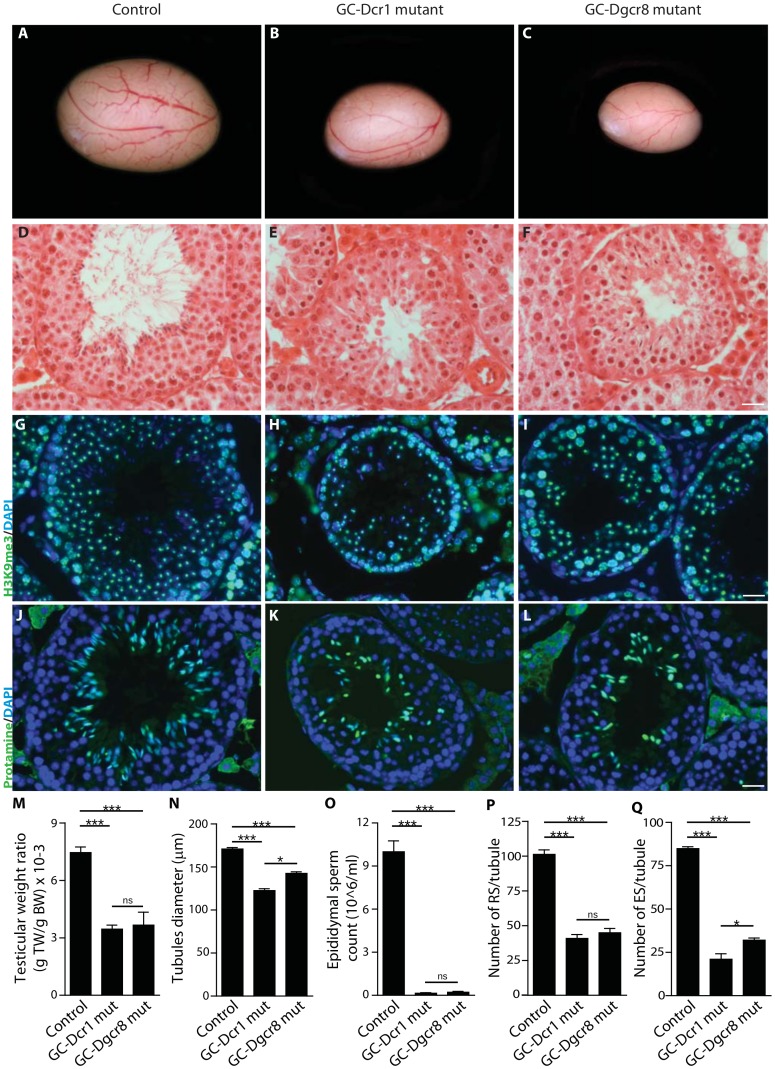
Reduction in testis size and near complete absence of mature spermatozoa in GC-Dcr1 and GC-Dgcr8 mutant mice.(A–C, M) At P60, testis weight showed a 55% and 50% reduction in GC-Dcr1 (n = 16) and GC-Dgcr8 mutants (n = 5) compared to control testes (n = 17). H&E staining of testis sections (D–F) revealed several defects in the architecture of the seminiferous epithelium, near complete absence of mature spermatozoa, and reduced tubular diameter (N) (Control: 170.9 µm2±1.7, GC-Dcr1 mut: 122.5 µm2±2.2, GC-Dgcr8 mut: 142.6 µm2±1.8). (G–I) Anti-H3K9me3 stained sex-body in round spermatids (RS). We observed a 60% reduction in the number of RS per tubule in GC-Dcr1 mutants and 55% reduction in GC-Dgcr8 mutants compared to control testes (P). (J–L) Anti-protamine revealed a 75% reduction in the number of elongated spermatids (ES) per tubule in GC-Dcr1 mutants and a 62% reduction in GC-Dgcr8 mutants compared to control testes (Q). DAPI (blue) was used for nuclear staining. (O) Epididymal sperm count analysis showed a 99% decrease in GC-Dcr1 mutants and 96% in GC-Dgcr8 mutants. TW: Testis Weight, BW: Body Weight, RS: Round Spermatids, ES: Elongated Spermatids. Results are mean ± SEM, * = p<0.05, ** = p<0.005, *** = p<0.0001 GC-Dcr1 mutant vs. control, GC-Dgcr8 mutant vs. control or GC-Dcr1 vs. GC-Dgcr8. Scale bars: 20 µm (D–L).